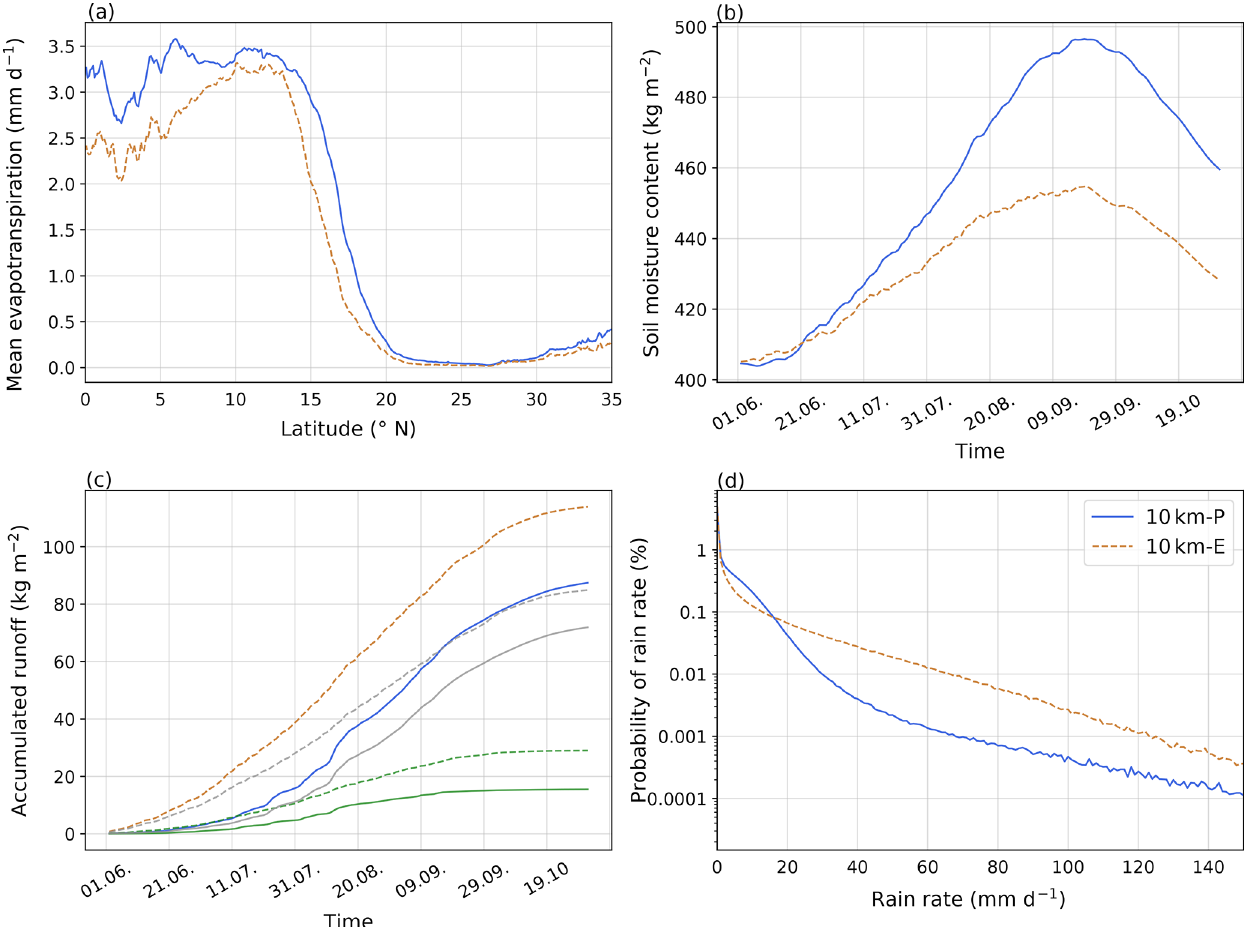
Figure A5. The same as Fig. 10 but for the 10km-P and 10km-E simulations.